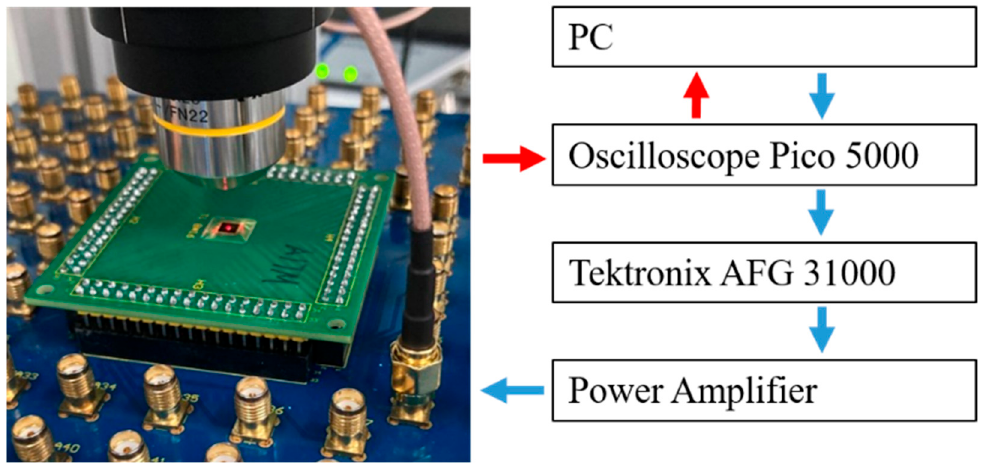
Figure 4. Laser Doppler vibrometer (LDV) setup for characterizing the PMUT performance.